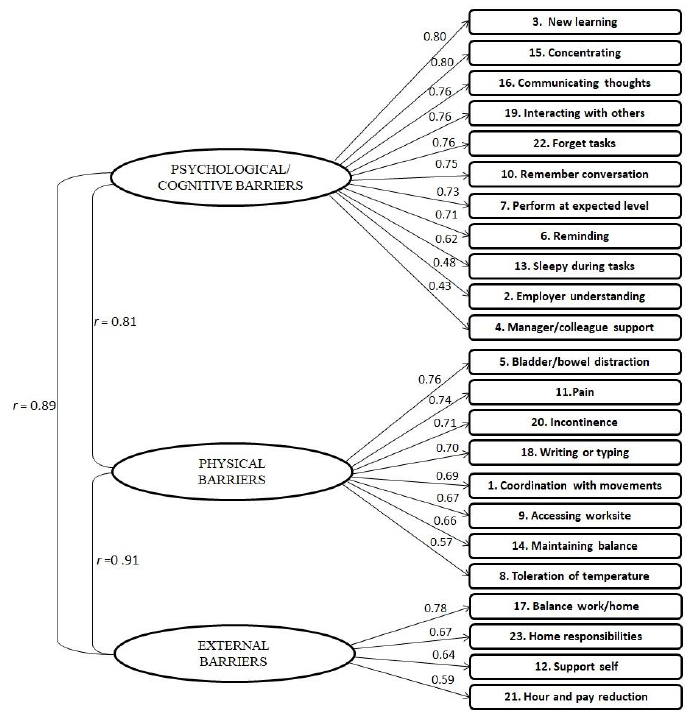
Figure 1. Factor structure of MSWDQ-23. The three latent factors (psychological/cognitive barriers, physical barriers, and external barriers) with their items (depicted in rectangles) and their standard- ized regression weights (i.e., factor loadings) are shown. The direction of the arrows represents the prediction of observed responses by the latent constructs. 3.3. Differences of Work Difficulties by Age, Gender, Education, Work Type, and MS Type Age was positively correlated with psychological/cognitive barriers (rho = 0.199, p = 0.005), physical barriers (rho = 0.238, p = 0.001), external barriers (rho = 0.247, p < 0.001), and total MSWDQ-23 scores (rho = 0.245, p = 0.001). The effect of sex on MSWDQ-23 scores was nonsignificant (see Table 2). PwMS with a lower level of education (i.e., primary/sec- ondary) had significantly more physical barriers in their work than those with higher ed- ucation (i.e., tertiary). Furthermore, PwMS with more work barriers were significantly more likely to work part-time than full-time. Finally, participants with RRMS had signif- icantly smaller MSWDQ-23 scores (i.e., less work barriers) than those with progressive MS (SPMS and PPMS). We considered the above findings as corroborative of the good construct and concurrent validity of the MSWDQ-23.